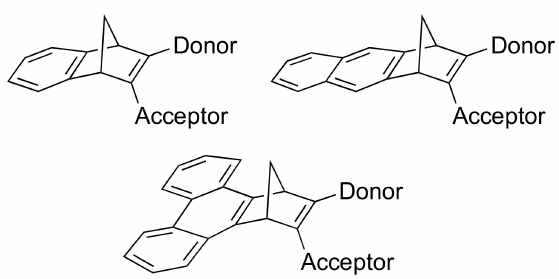
Figure 1. Norbornadiene target molecules with fused aromatic units at one double bond and donor-acceptor substituent groups at the other double